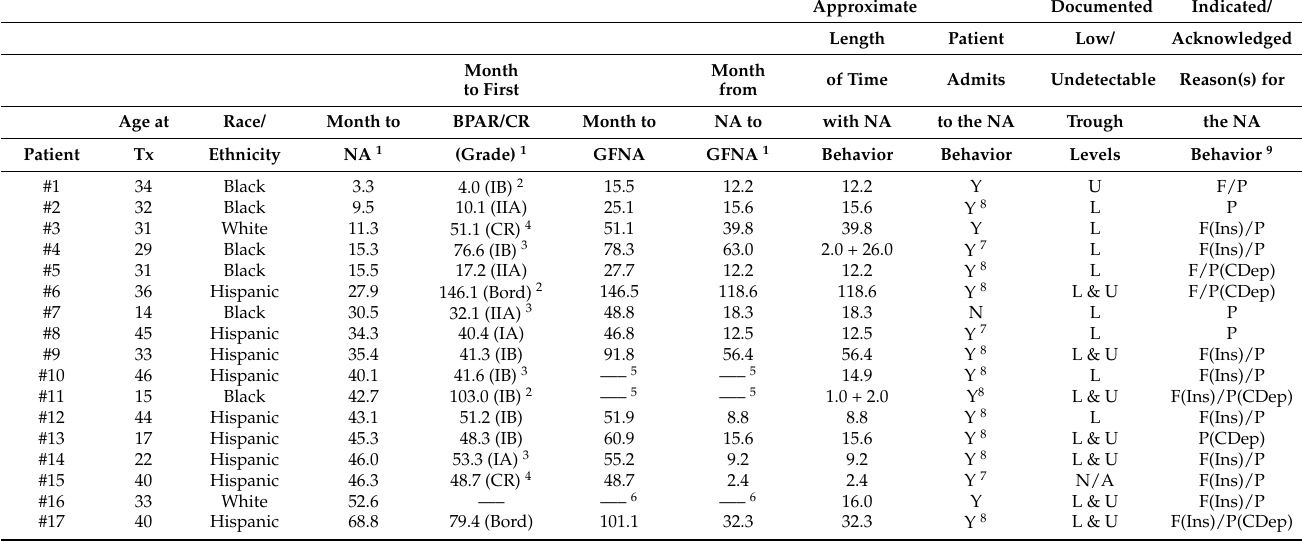
Table 6. Descriptive characteristics for each of the 28 patients who became nonadherent (NA) (listed by shortest to longest time to